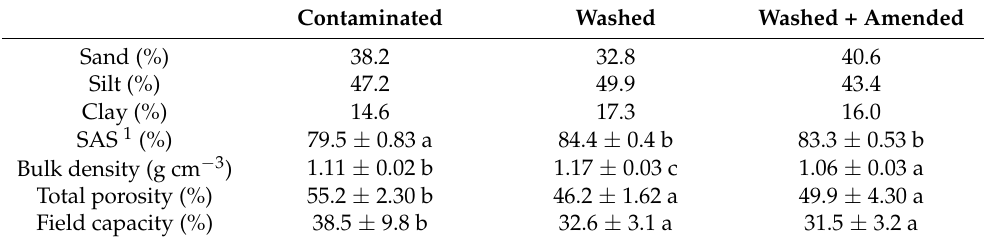
Table 2. Physical properties of the soil treatments at the start of the experiment (mean ± SD, n = 4). Lower case letters indicate significant differences between groups (Dunn test p < 0.05). Soil texture was determined in duplicates.